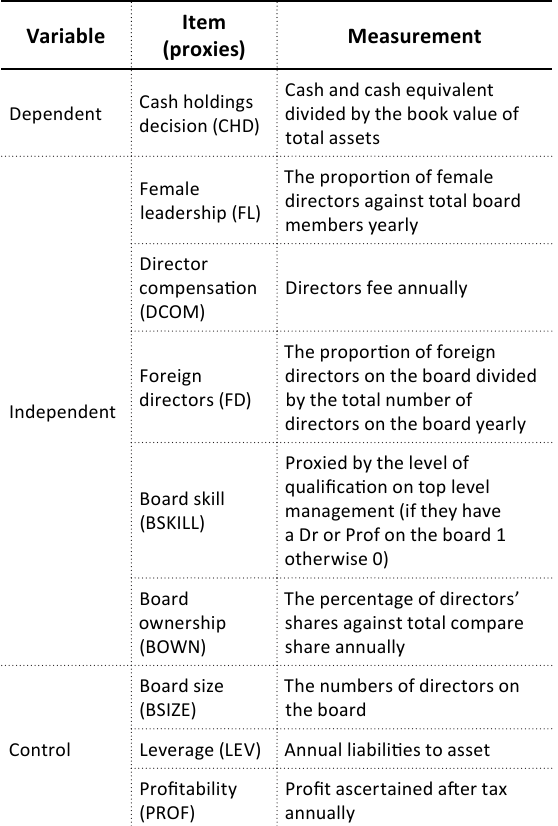
Table 1. Summary of